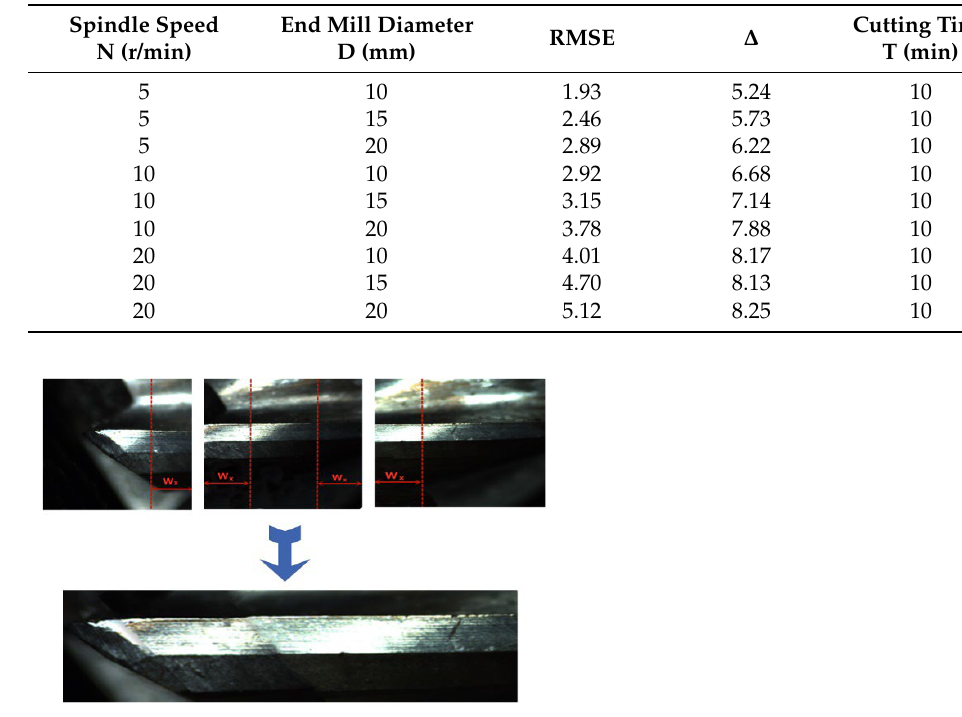
Table 1. Image evaluation results under different parameters of the registration model.